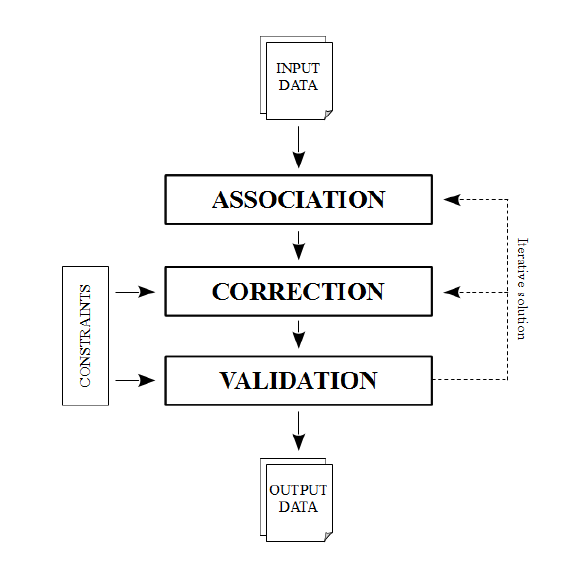
Figure 1: Global architecture of the conflation process ciation and correction steps, trying different possibilities on un- certain building-parcel couples until the correction is satisfying.